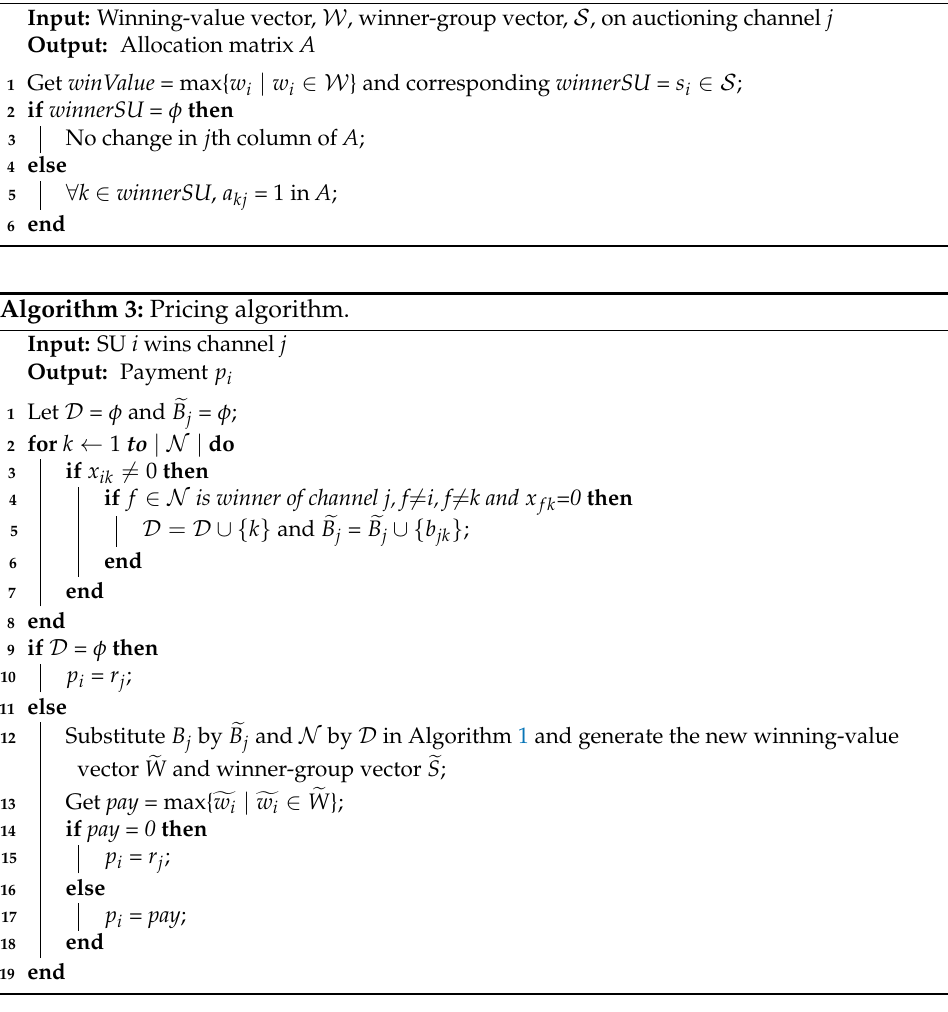
Algorithm 2: Spectrum-allocation algorithm.